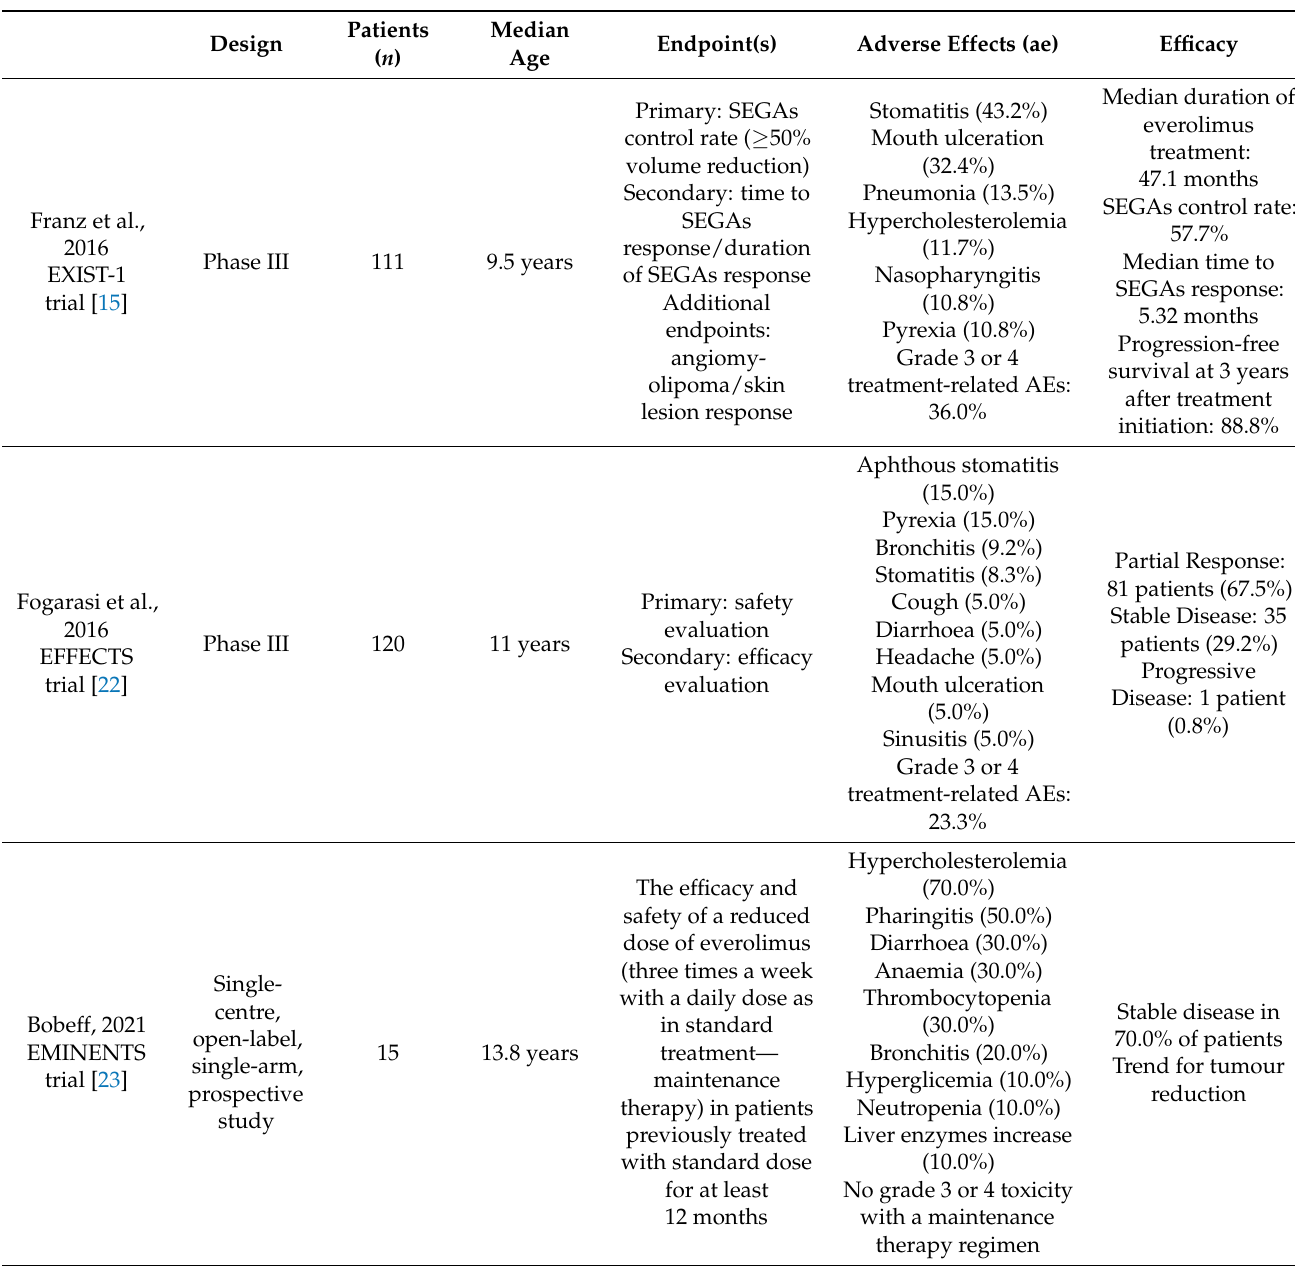
Table 1. Main studies investigating the role of mTOR inhibitor everolimus in subependymal giant cell astrocytomas (SEGAs) of tuberous sclerosis complex